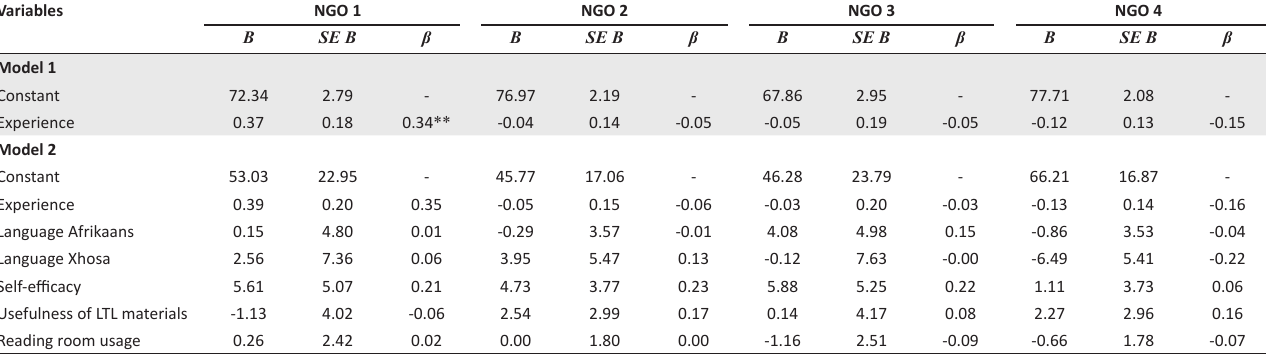
TABLE 5: Summary of hierarchical regression analysis for variables predicting Living through Learning literacy outcomes.